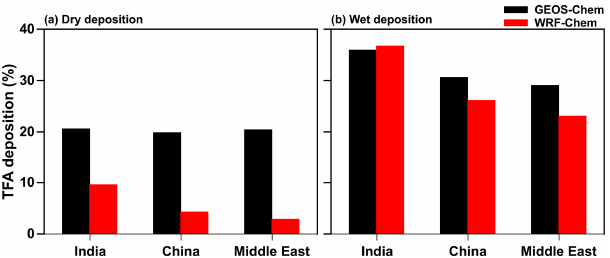
Figure 7. Percentage contribution of (a) dry and (b) wet deposition to total annual TFA deposition simulated in GEOS-Chem and WRF- Chem in the three domains.